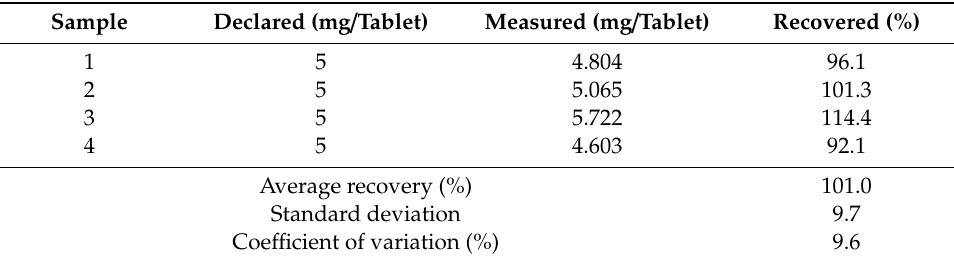
Table 4. Recovery data for vitamin B1 in a commercially available multivitamin tablet.